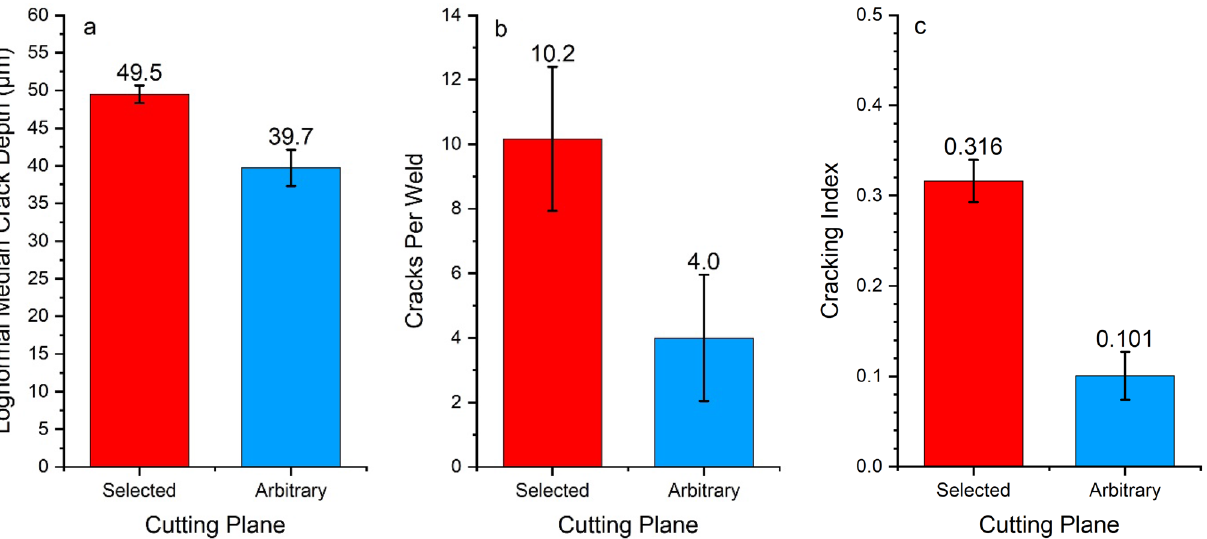
Fig. 4 Comparison of the a lognormal median of measured cracks depths, b cracks per welds and c cracking index measured from welds cross-sectioned from both selected and arbitrary cross-sectioning